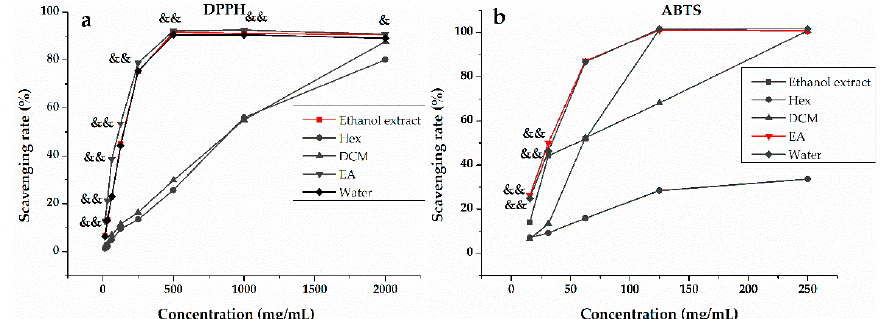
Figure 1. The scavenging rate (%) of the ethanol extract, n -hexane (Hex), dichloromethane (DCM), ethyl acetate (EA), and water fractions of H. abyssinica : ( a ) the radical scavenging rate (%) of 2,2-diphenyl-1-picrylhydrazyl (DPPH) and ( b ) the radical scavenging rate (%) of 2,2’-azino-bis(3-ethylbenzthiazoline-6-sulfonic acid (ABTS). All of the values in the figure are expressed as means (%) and SD of triplicated experiments. & p < 0.05, && p < 0.01, compared with the ethanol extract.